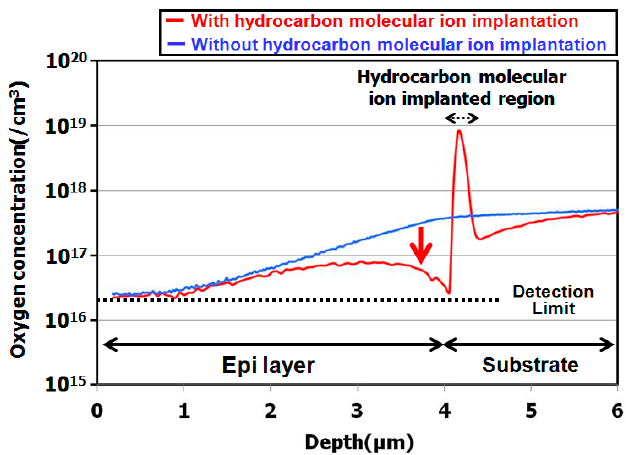
Figure 5. SIMS depth profile of oxygen impurity with and without hydrocarbon–molecular–ion–implanted epitaxial silicon wafers after heat treatment. Modified from Kurita et al. [28], Copyright (2015) The Japan Society of Applied Physics.